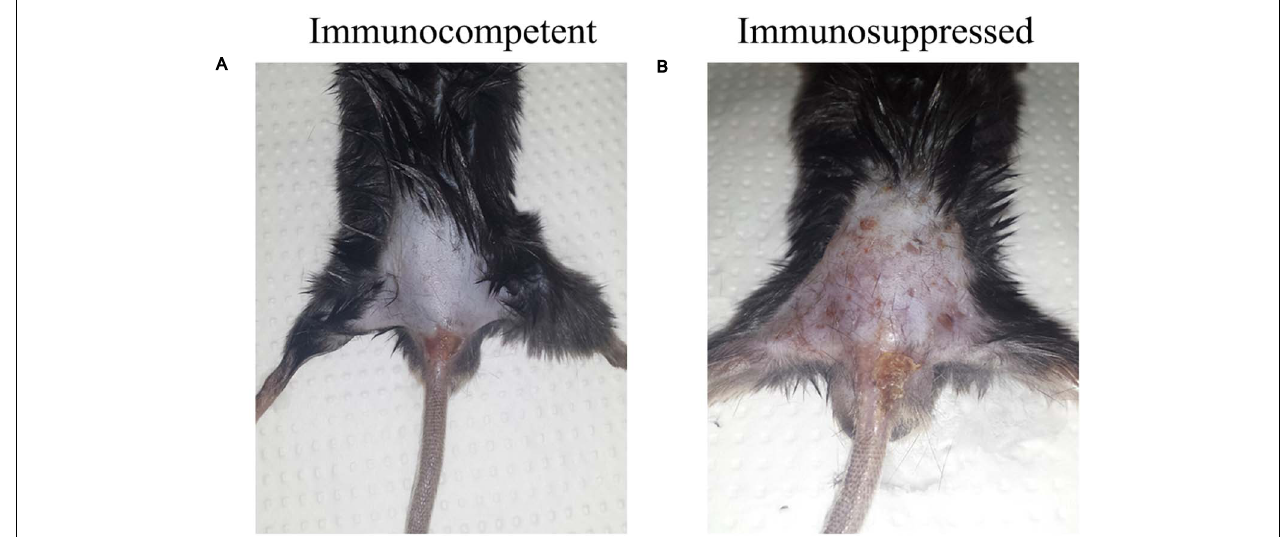
FIGURE 1 | Macroscopic aspects of the epidermis of the immunocompetent (CI) and immunosuppressed (SI) mice inoculated at the tail base with 1 × 10 5 conidia of Purpureocillium lilacinum on day 5 after infection. (A) Discreet, non-ulcerative, and non-suppurative lesion at the point of inoculation; (B) Crusted lesion at the point of inoculation, extending to the base of the